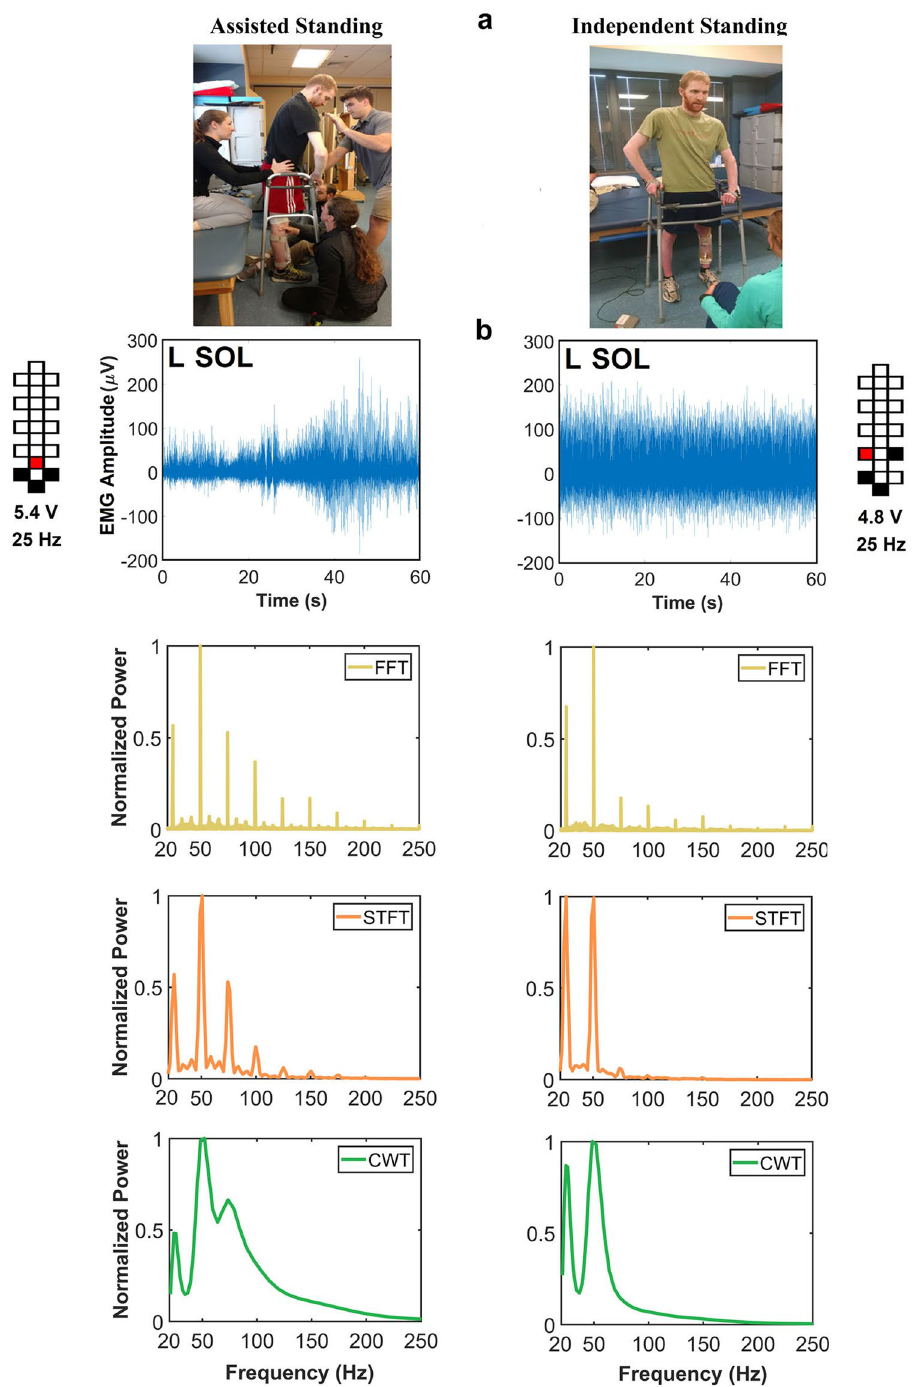
Figure 2. Spectral power density of EMG collected during standing. ( a) Exemplary images of assisted standing (left) and independent standing (right). ( b) EMG activity recorded from the left soleus (L SOL) of research participant A45 during assisted standing (left) and independent standing (right) with epidural stimulation, and related spectral power density generated by Fast Fourier Transform (FFT), Short-Time Fourier Transform (STFT) and Continuous Wavelet Transform (CWT). Stimulation amplitude, frequency and electrode configuration (cathodes in black, anodes in red, and inactive in white) are